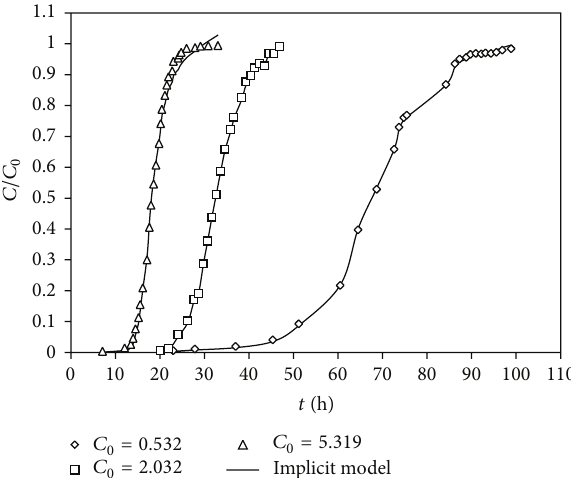
Figure 7: Breakthrough curves of phenol adsorption onto resin NDA-100 fitted with (2) [35].